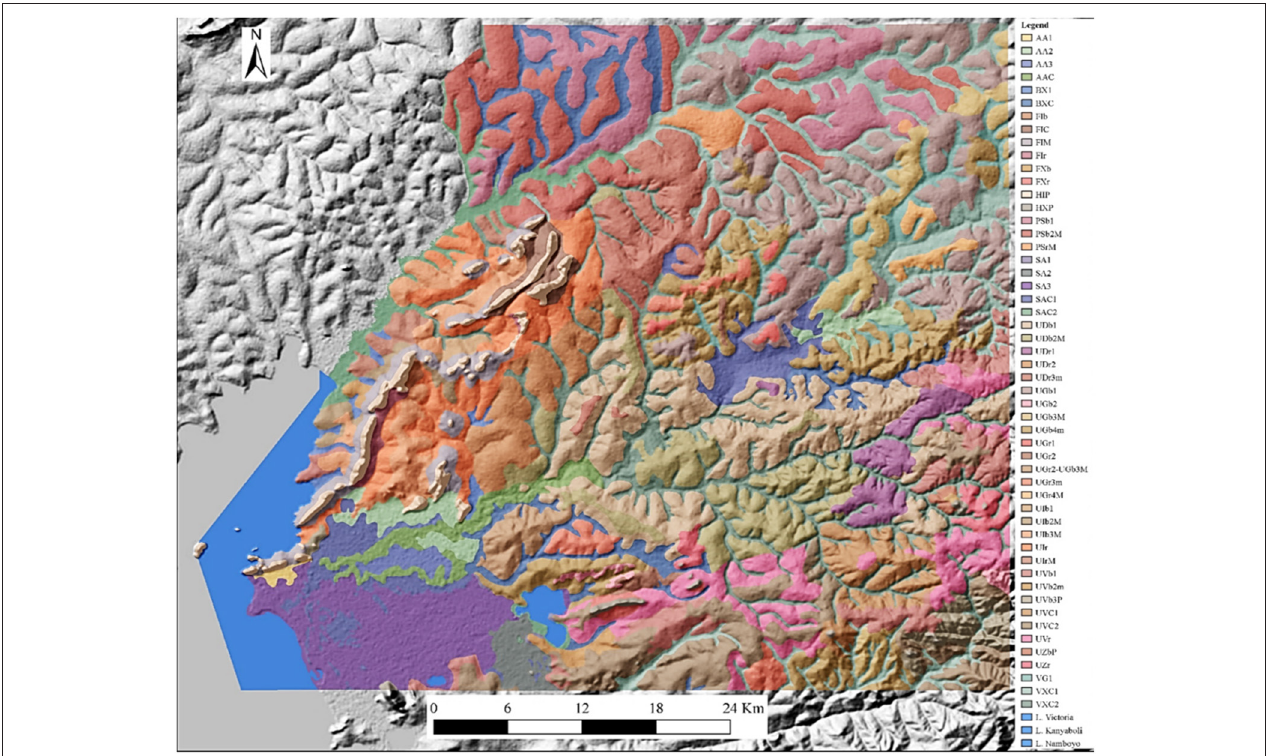
FIGURE 7 | Digitized soil map of the Busia area. Colors of the soil map units are like those used by Rachilo and Michieka (42) and were determined and used to reproduce the map, which was then overlaid on the hillshade basemap with transparency set to 45% for a 3-dimensional